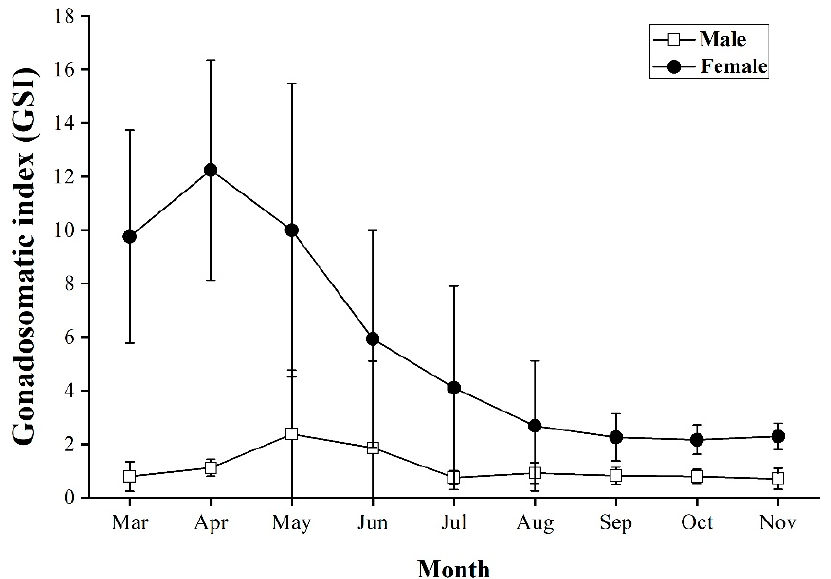
Figure 7. Monthly gonadosomatic index ( GSI ) of Pseudecheneis sulcatus males and females in the lower Yarlung Zangbo River between March and October 2016. Values are expressed as means ± SD.